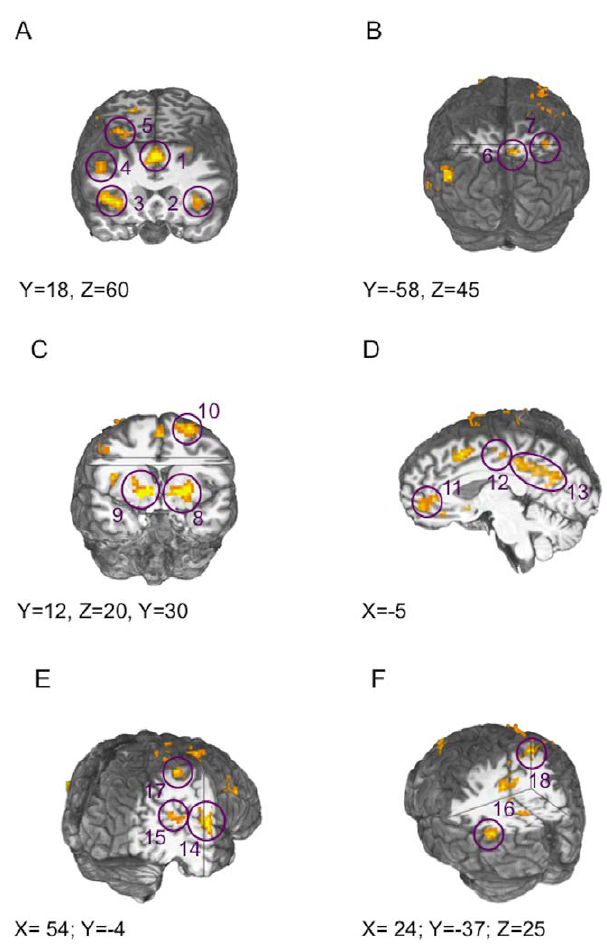
Figure 3. Brain regions showing main effects of FEEDBACK VALENCE on BOLD responses (Talairach coordinates of each slice listed at the bottom of each panel). ( A ) BOLD ACTIVATIONS in response to negative (relative to positive) feedback are evident in insula/vlPFC, dmPFC, dlPFC, and ( B ) posterior parietal cortex, in the entire sample. ( C ) BOLD DEACTIVATIONS in response to negative (relative to positive) feedback are evident in ventral striatum, ( D ) anterior and posterior cingulate cortex, ( E ) lateral temporal cortex, and ( F ) posterior parietal cortex, in the entire sample.